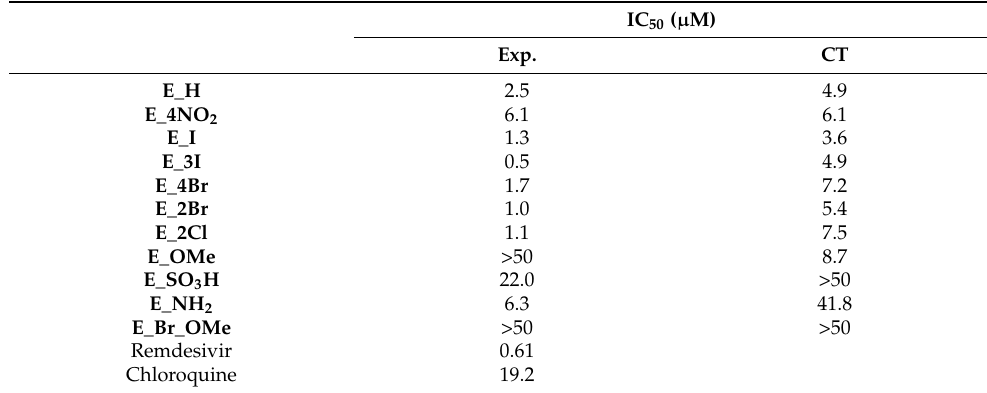
Figure 6. IC 50 curves representing the anti-HCoV-NL63 effects of emodin and emodin derivatives. Table 5. IC 50 ( µ M) values corresponding to the anti HCoV-NL63 effects (AV) and the effects on Vero cell viability (expressed as IC 50 values, CV) of each of the tested compounds.